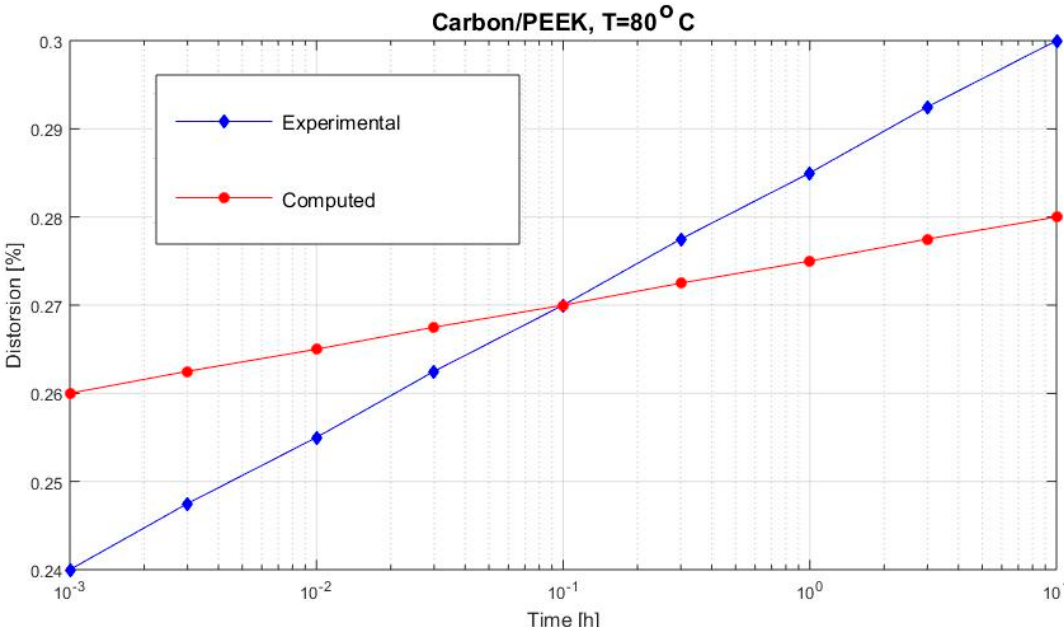
γ (carbon/PEEK subjected to